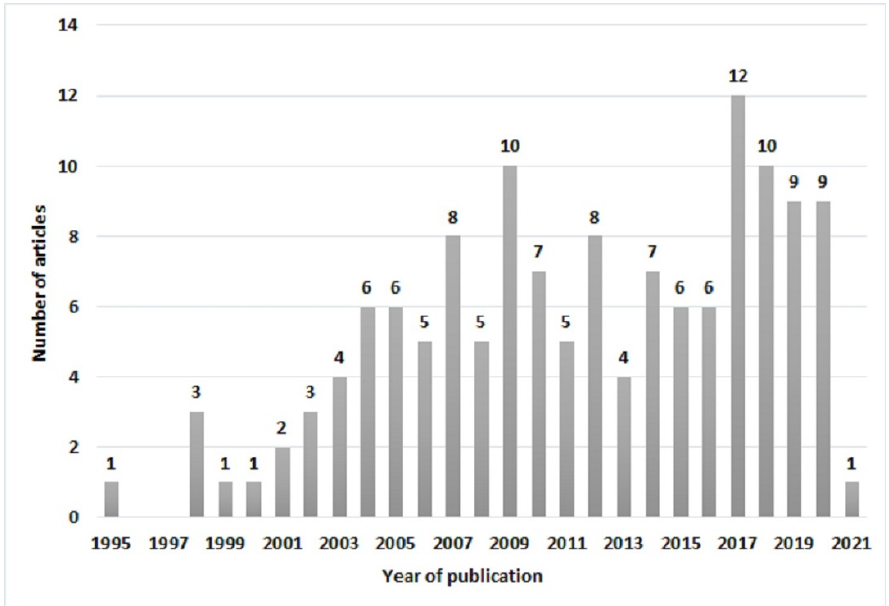
Figure 3. Distribution of reviewed articles based on the publication year.